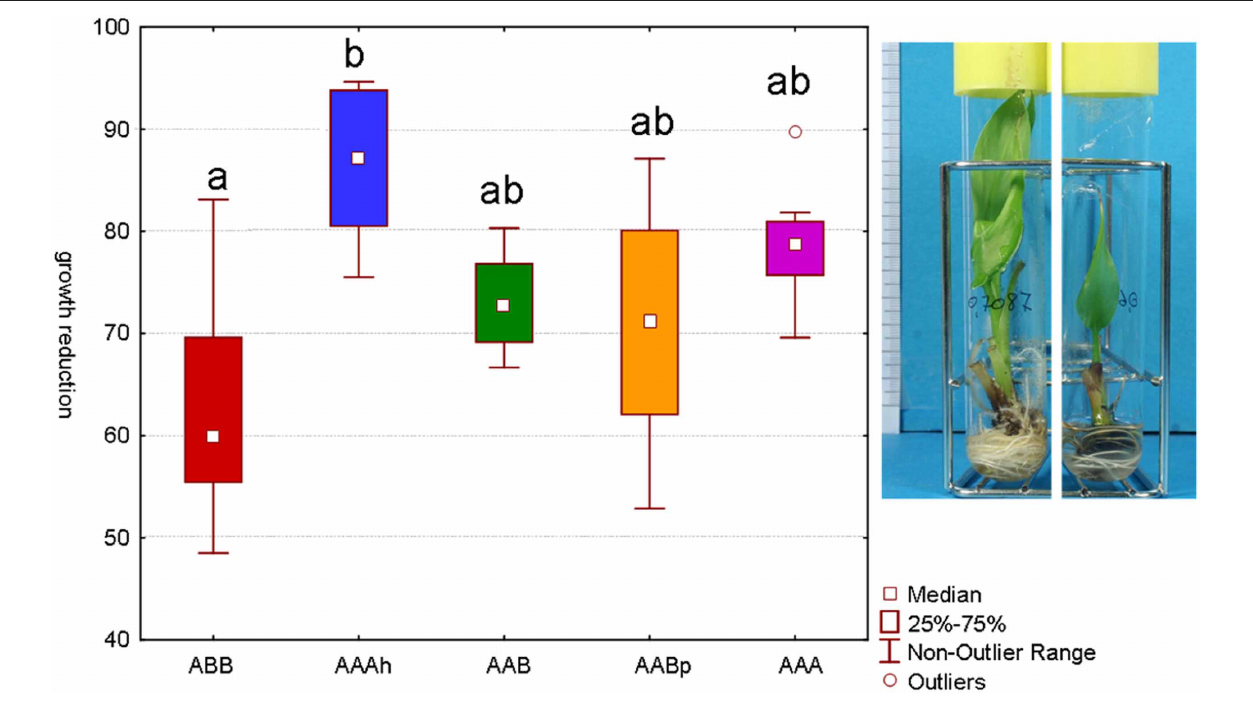
FIGURE 2 | Growth reduction after 48 days of sorbitol (0.2M) stressed plantlets versus their control ( α 0.05, n = 7 − 8). Bars marked with the same letter do not differ significantly from each other; a < b. The picture of